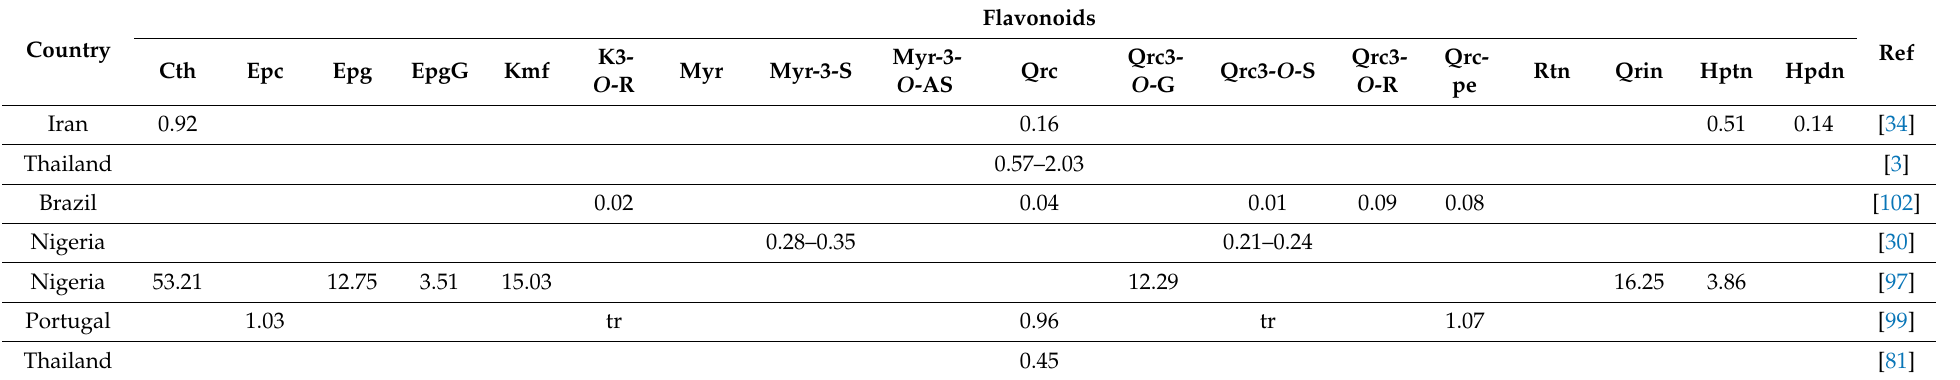
Table 5. Flavonoid compounds from roselle calyx (mg/g). Abbreviations: N/A: not available, nd: not detected, tr: trace, Cth: (+)-Catechin, Epc: Epicatechin, Epg: (-)epigallocatechin, EpgG: (-)epigallocatechin gallate, Kmf: Kaempferol, K3- O -R: Kaempferol 3- O -rutinoside, Myr: Myricetin, Myr-3-S: Myricetin 3-sambubioside, Myr-3- O -A: Myricetin 3- O -arabinogalactoside, Qrc: Quercetin, Qrc3- O -G: quercetin 3- O -glucoside, Qrc3- O -S: Quercetin 3-sambubioside, Qrc3- O -R: Quercetin 3-rutinoside, Qrc-pe: Quercetin-pentosylhexoside, Rtn: Rutin, Qrin: